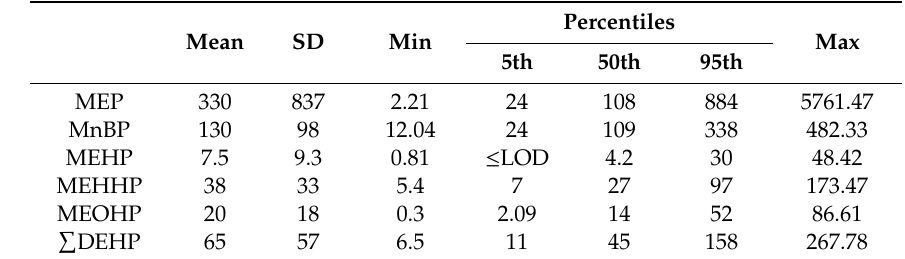
Table 6. Descriptive statistics of concentrations of phthalate metabolites (ng / mL) in study group (n =